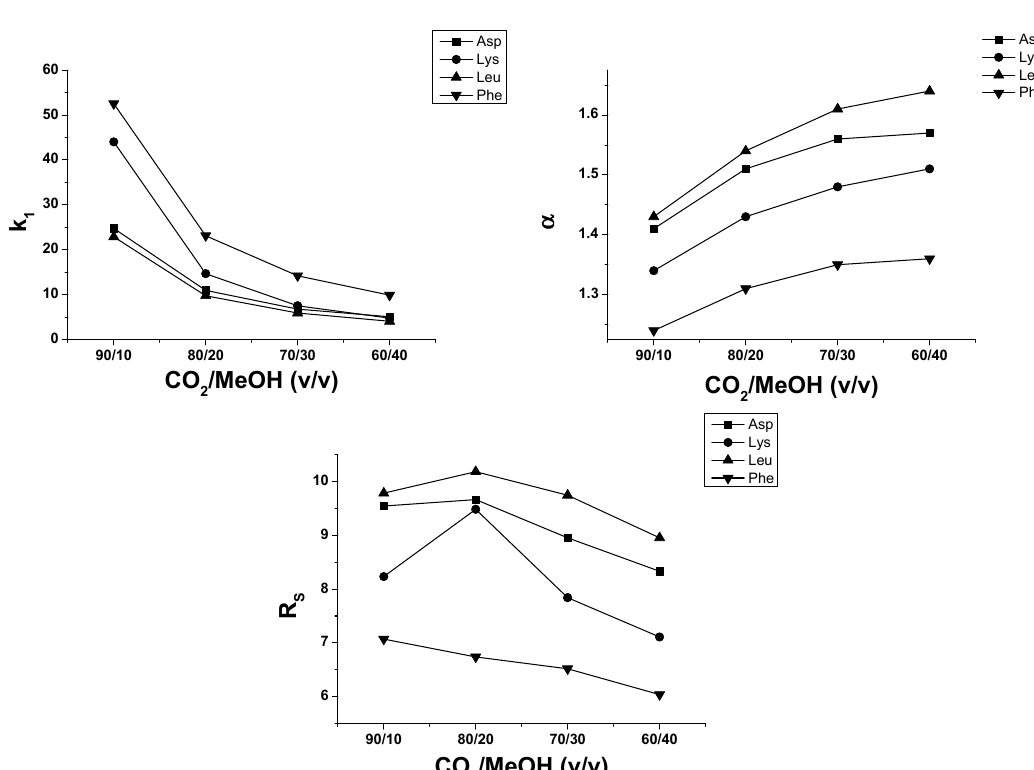
Figure 6. Effect of bulk solvent composition for chromatographic parameters k 1 , α and R S of selected SAs on QN-AX™ at SFC conditions. Chromatographic conditions: column, QN-AX™; mobile phase, CO 2 /MeOH (90/10, 80/20, 70/30 and 60/40 v/v ) containing of 30.0 mM TEA and 60.0 mM FA; flow rate, 2.0 mL · min − 1 ; T col , 40 ◦ C; back pressure, 150 bar; detection, 262 nm. Symbols for k 1 , α and R S : (cid:4) for Fmoc-Asp(O t Bu)-OH; (cid:72) for Fmoc-Phe-OH; (cid:78) for Fmoc-Leu-OH; and for Fmoc-Lys(Boc)-OH.